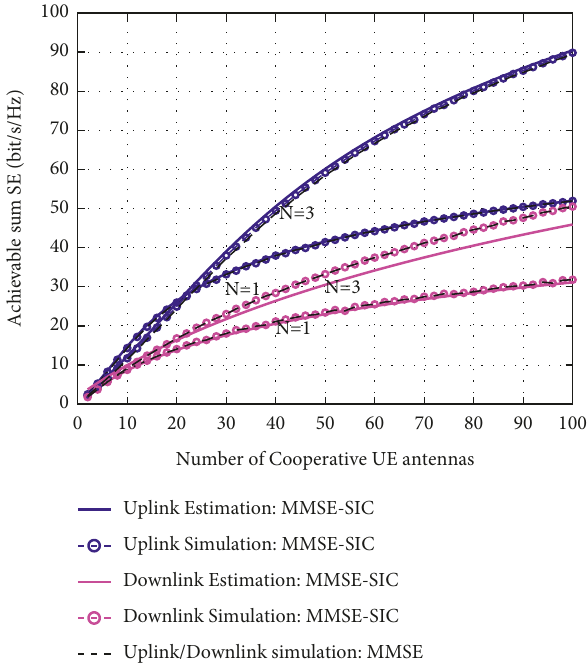
Figure 5: The total amount of obtained SE as a function of the number of PU antennas. M � 2, ... , 100 in uplink, downlink for N � {1,3}, k � 10.